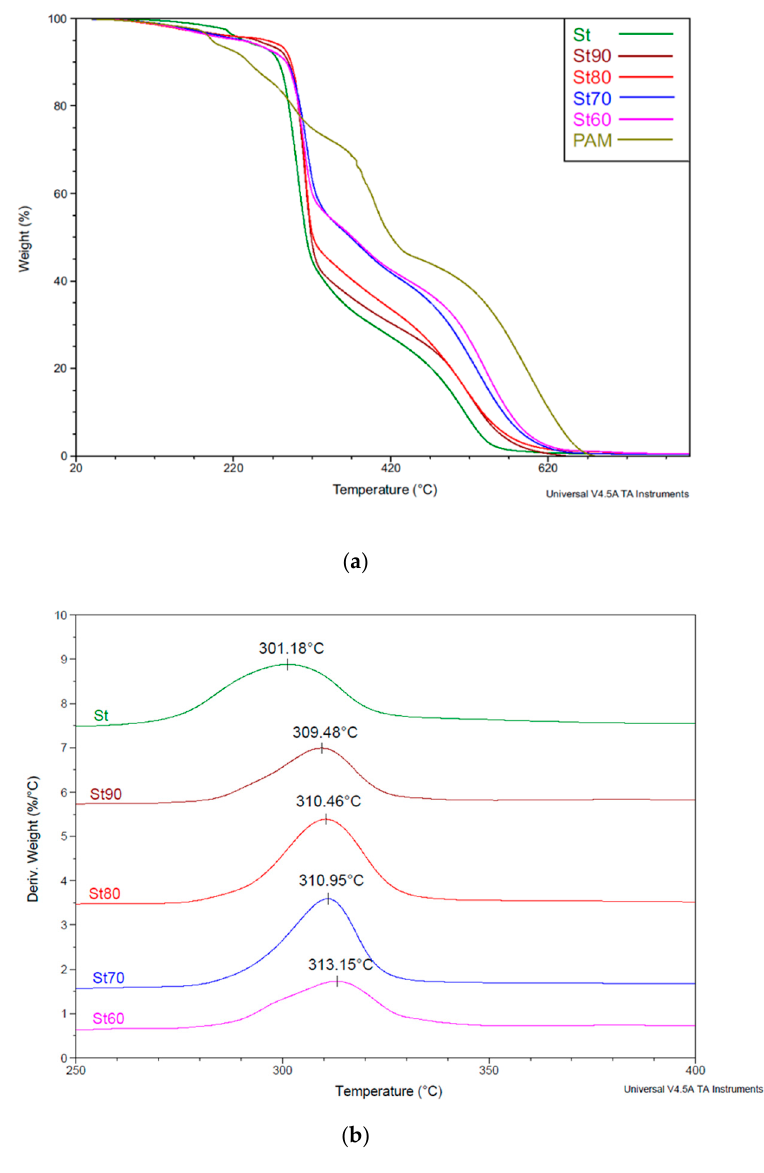
Figure 5. The thermogravimetric curves ( a ) St, polyacrylamide-PAM, St90, St80, St70 and St60; ( b ) DTG curves of starch St and starch SAPs.